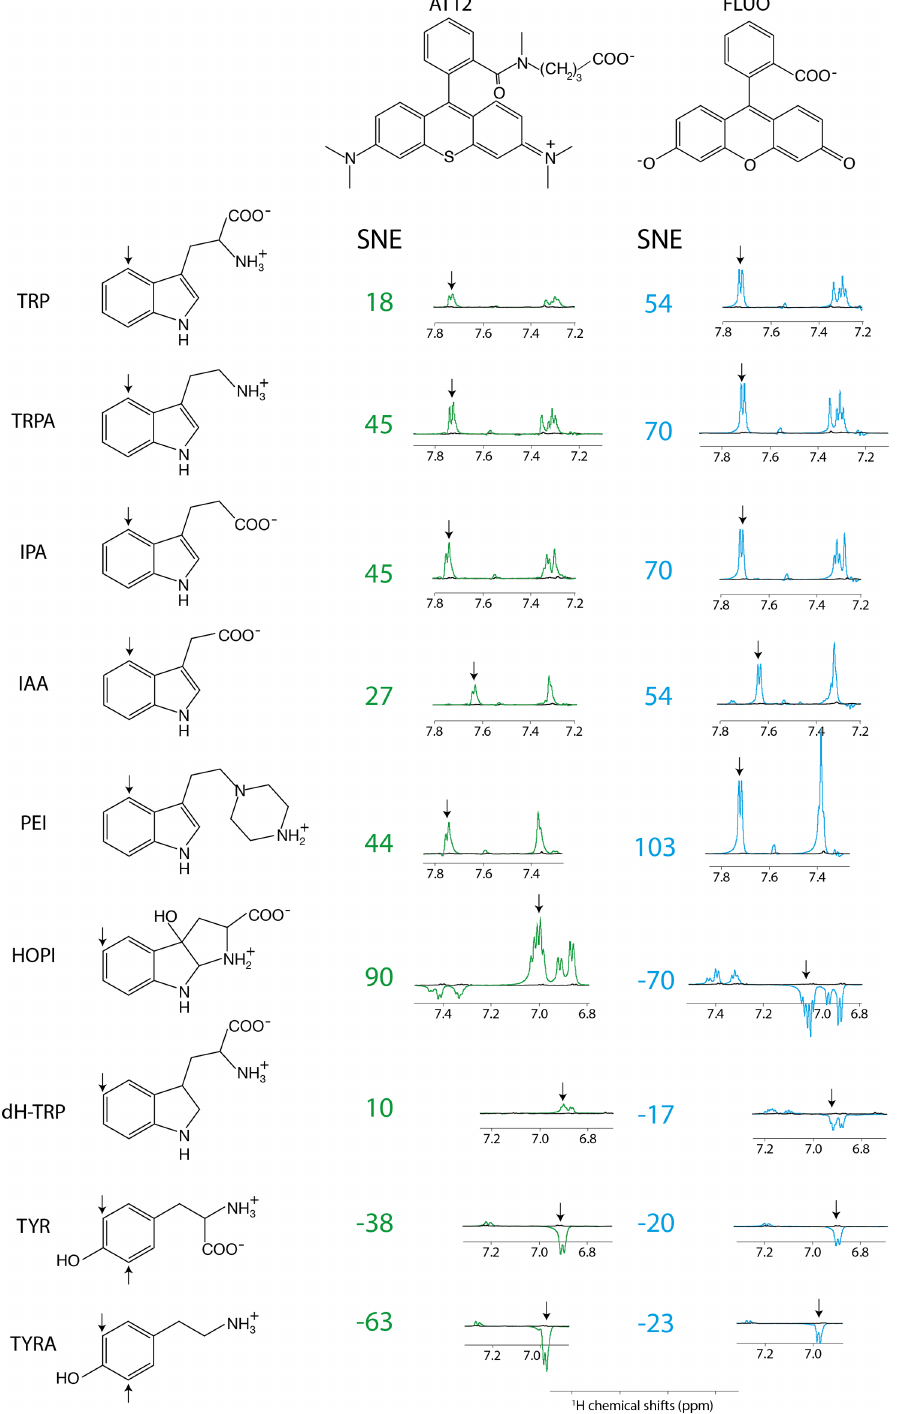
Figure 1. Photo-CIDNP spectra of tryptophan or tyrosine derivatives. The best aromatic proton’s signal-to-noise enhancement (SNE) is provided, and the corresponding signal is pinpointed with an arrow. All spectra were recorded after 4s of irradiation at 1W, in the presence of either AT12 (20µM, irradiation wavelength 532nm) or fluorescein (20µM, irradiation wavelength 450nm), the to-be-polarized molecule is present in a concentration of 100µM. Color code: green are the AT12-monitored SNE values and photo-CIDNP spectra, blue are the fluorescein-monitored SNE values and photo-CIDNP spectra, and black are the non-irradiated reference spectra. The structures are provided in their ionization state at experimental conditions of